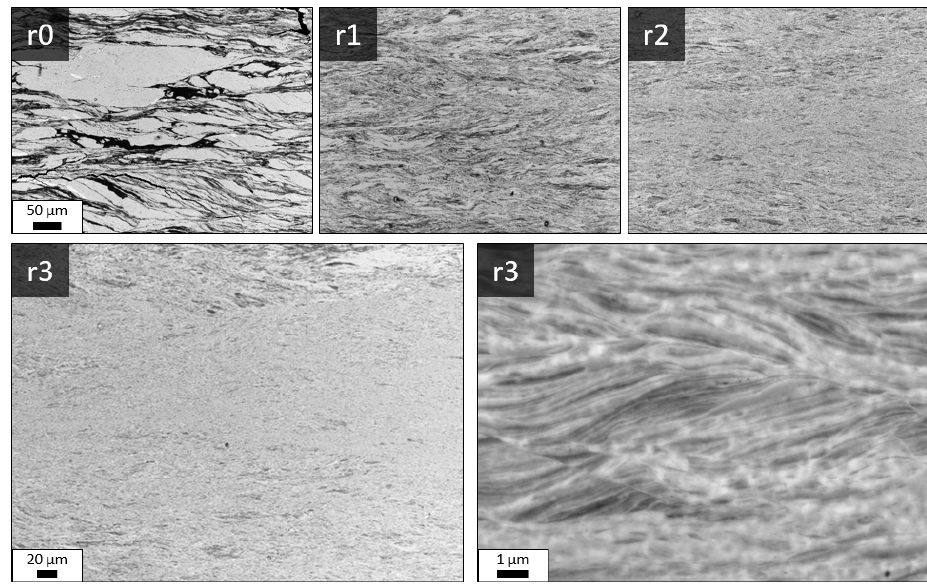
Figure A2. BSE images of a HPT-deformed sample (Nr. 2) at RT consisting of 24 wt.% Fe–76 wt.% SmCo 5 at different radii. The scale bar in r0 also applies to r1 and r2. Images of two magnifications are presented for r3.